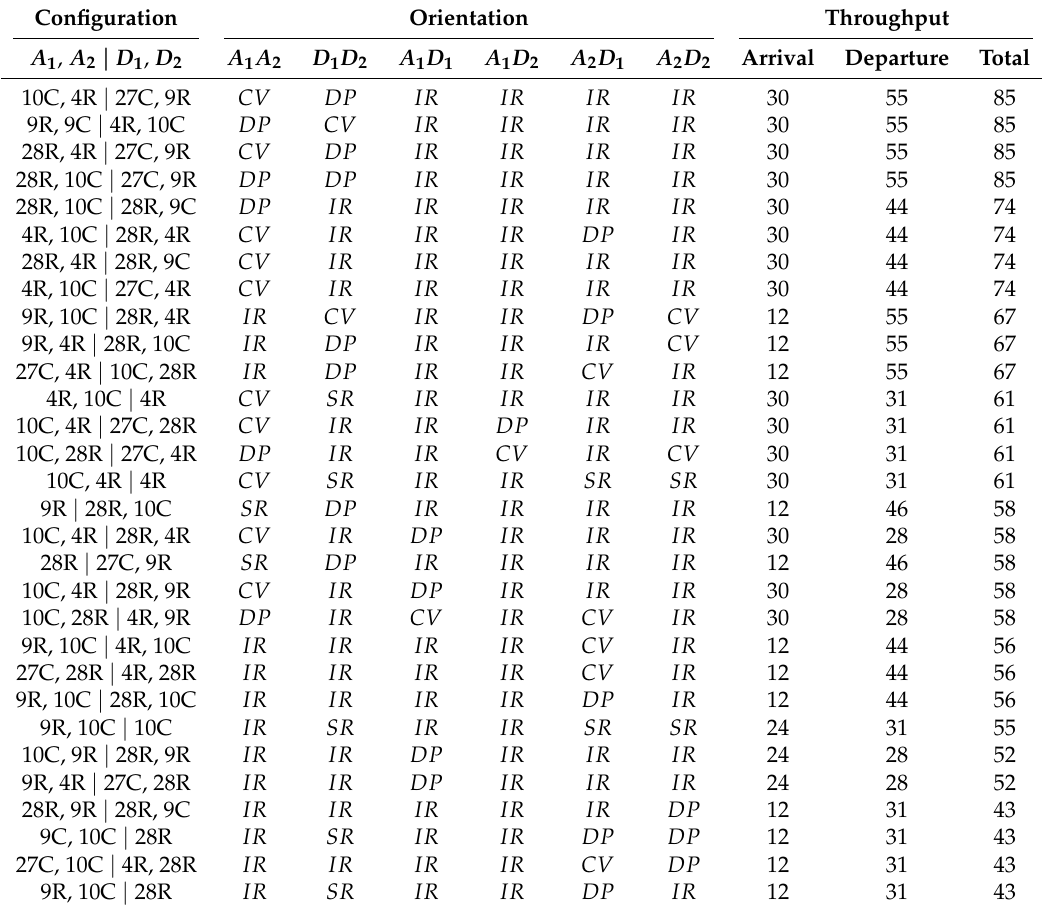
Table 4. Feasible runway configuration and throughput: 30 best runway configurations that accommodate the maximum numbers of arriving and departing